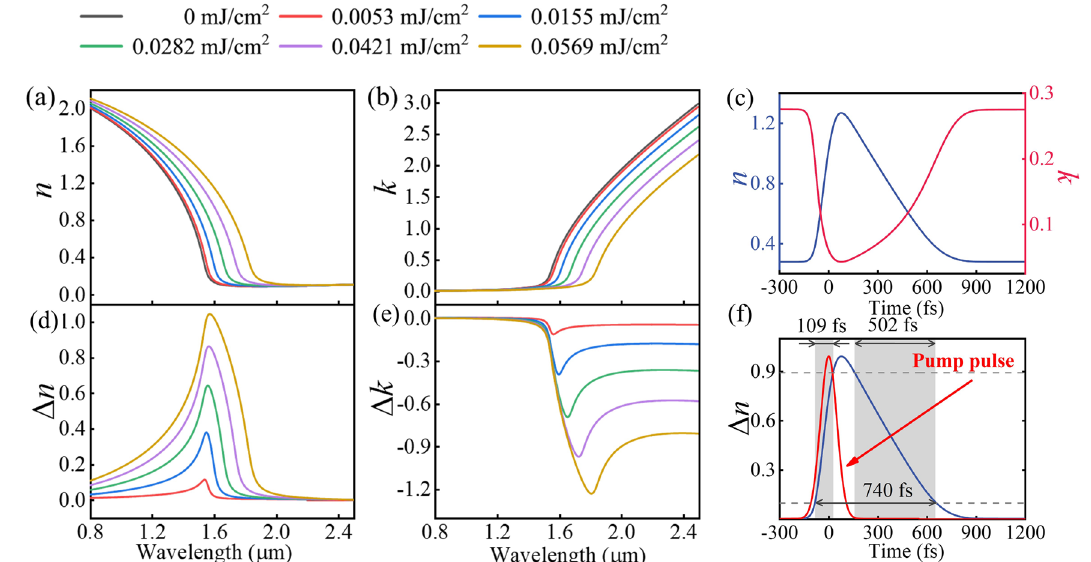
Figure 3. ( a ) Refractive index n , ( b ) absorption coefficient k , and ( c ) the transient response of n and k under F = 0.0569 mJ cm −2 at ENZ wavelength 1.55 μm. ( d ) The changes of refractive index Δ n , ( e ) absorption coefficient Δ k , and ( f ) the ultrafast change Δ n in time domain at ENZ wavelength. The red curve denotes the pulse intensity profile (in arbitrary units).